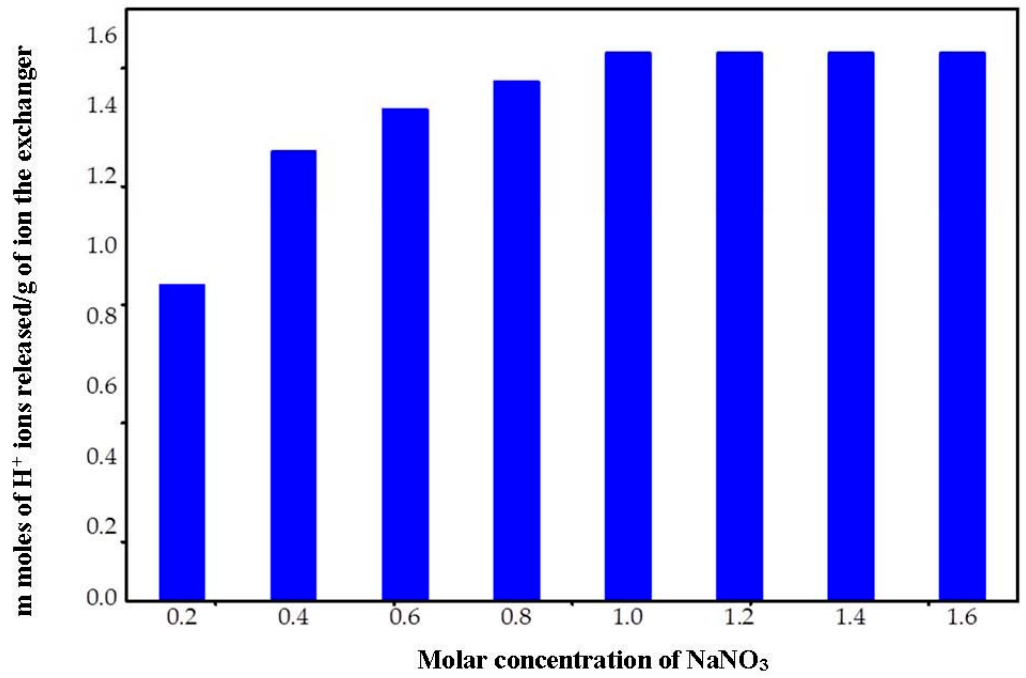
Figure 3. Effect of eluent concentration on the ion-exchange capacity of graphene Th(IV) phosphate cation exchanger.